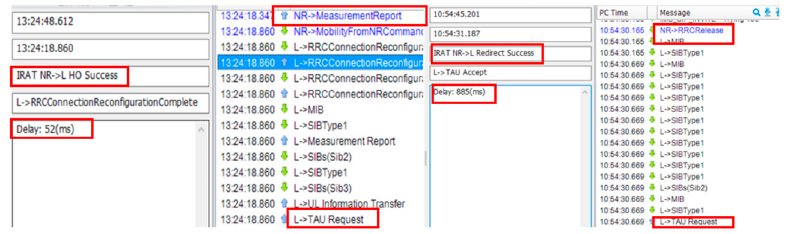
Figure 16. Delay of EPS fallback based on handover/redirection.